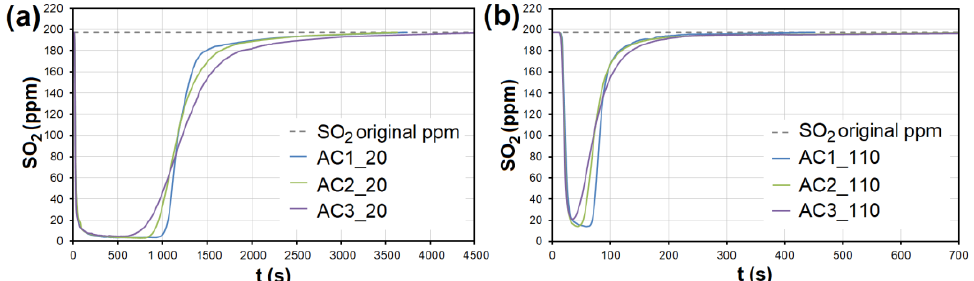
Figure 9. The adsorption curves showing SO 2 adsorption on AC at adsorbent temperatures of ( a ) 20 °C and ( b ) 110 °C. AC1-3 — activated carbon at different granulometric fractions (see Table 1).